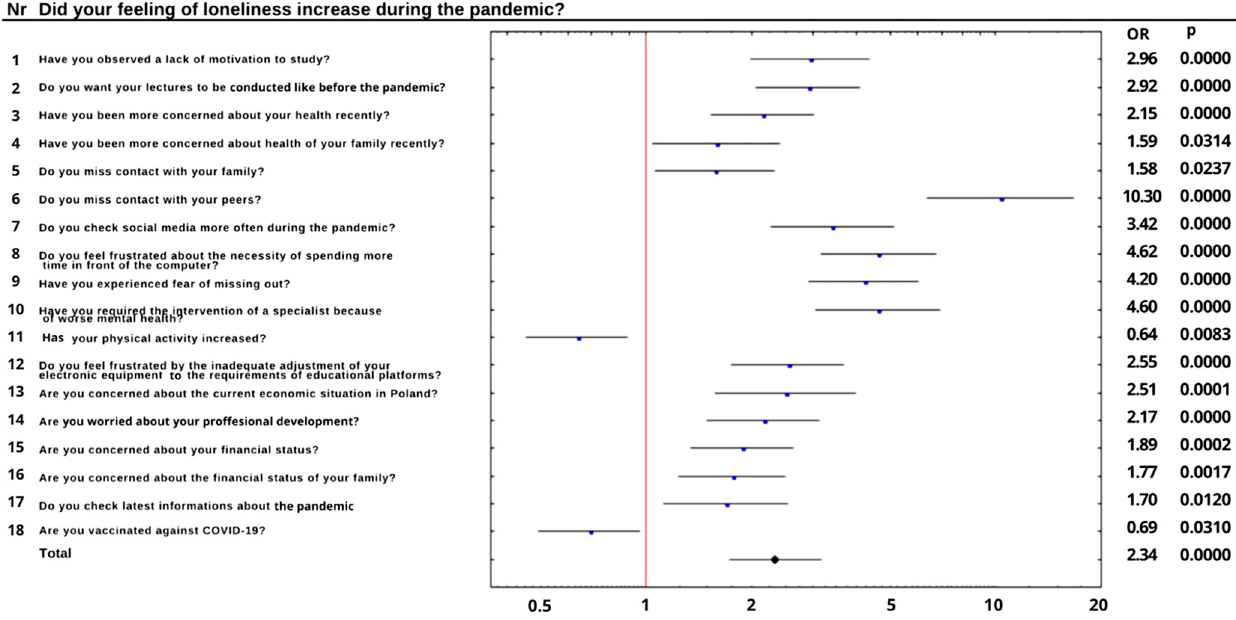
Figure 1. The impact of the feeling of loneliness on other variables.